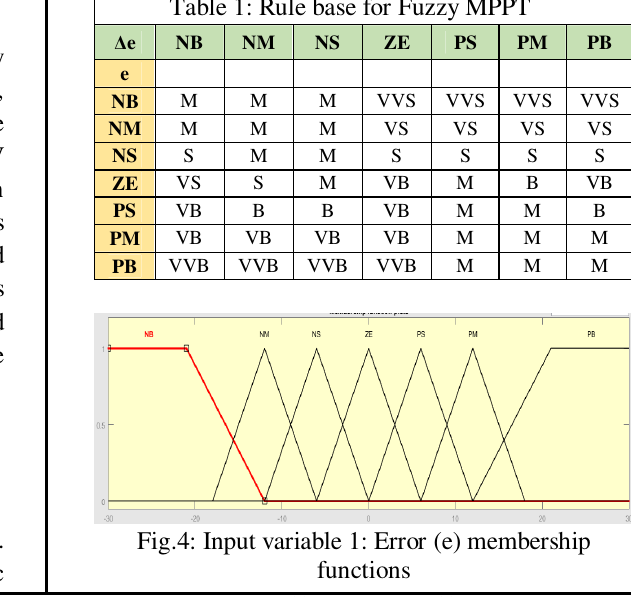
Table 1: Rule base for Fuzzy MPPT